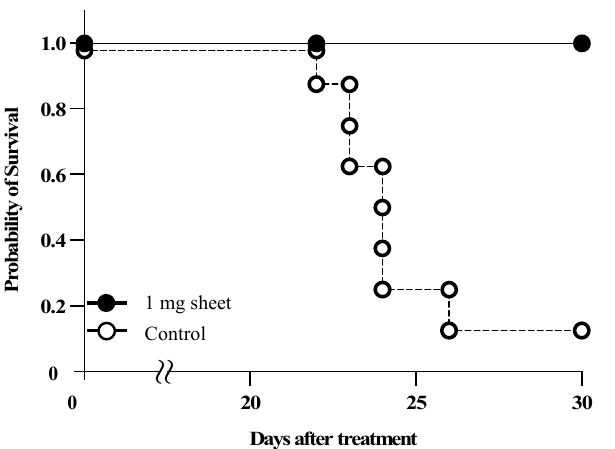
Figure 7. Effect of lenvatinib sheets on survival in a mouse peritoneal seeding model. In total, 5 × 10 7 HuH-7-Luc cells were intraperitoneally transplanted into BALB/c nude mice, and simultaneously, the sheets were inserted subcutaneously. The Kaplan–Meier survival curves represent the cumulative survival of the following treatment groups in one experiment: control ( n = 8; open circles) and 1 mg sheet ( n = 10; filled circles) groups. p < 0.001 compared with the control group (by the log-rank test).